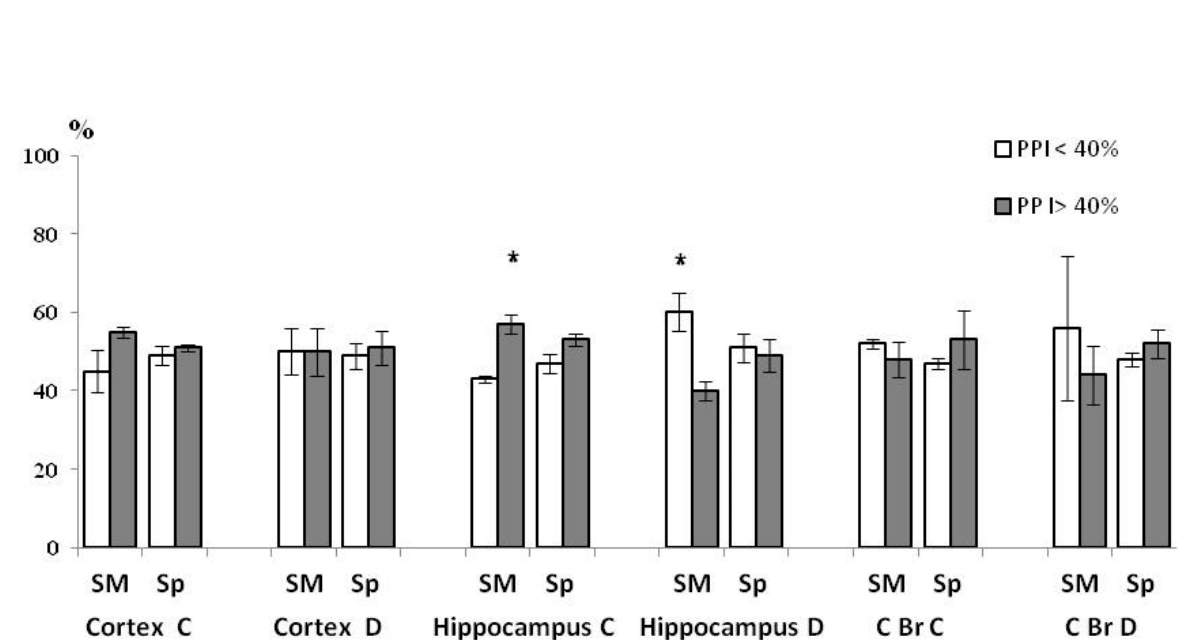
sub-group, taken as 100%. Cortex, neocortex; C Br, caudal brainstem; C, the fraction of light synaptosomes; D, the fraction